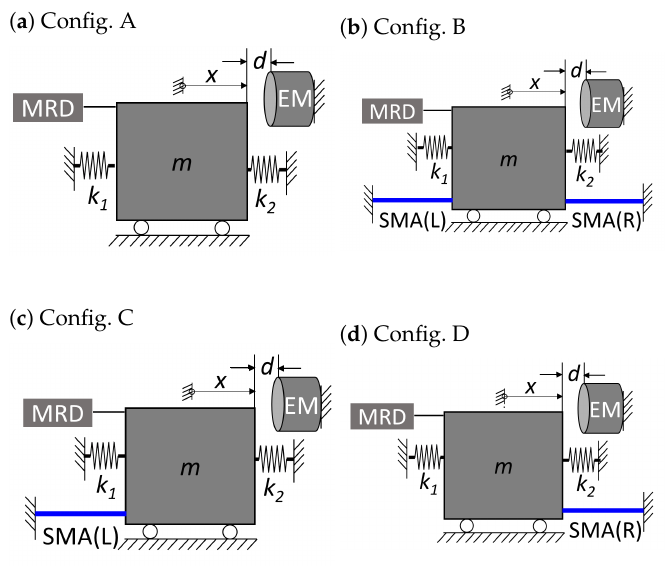
Figure 10. Various test configurations of the experimental